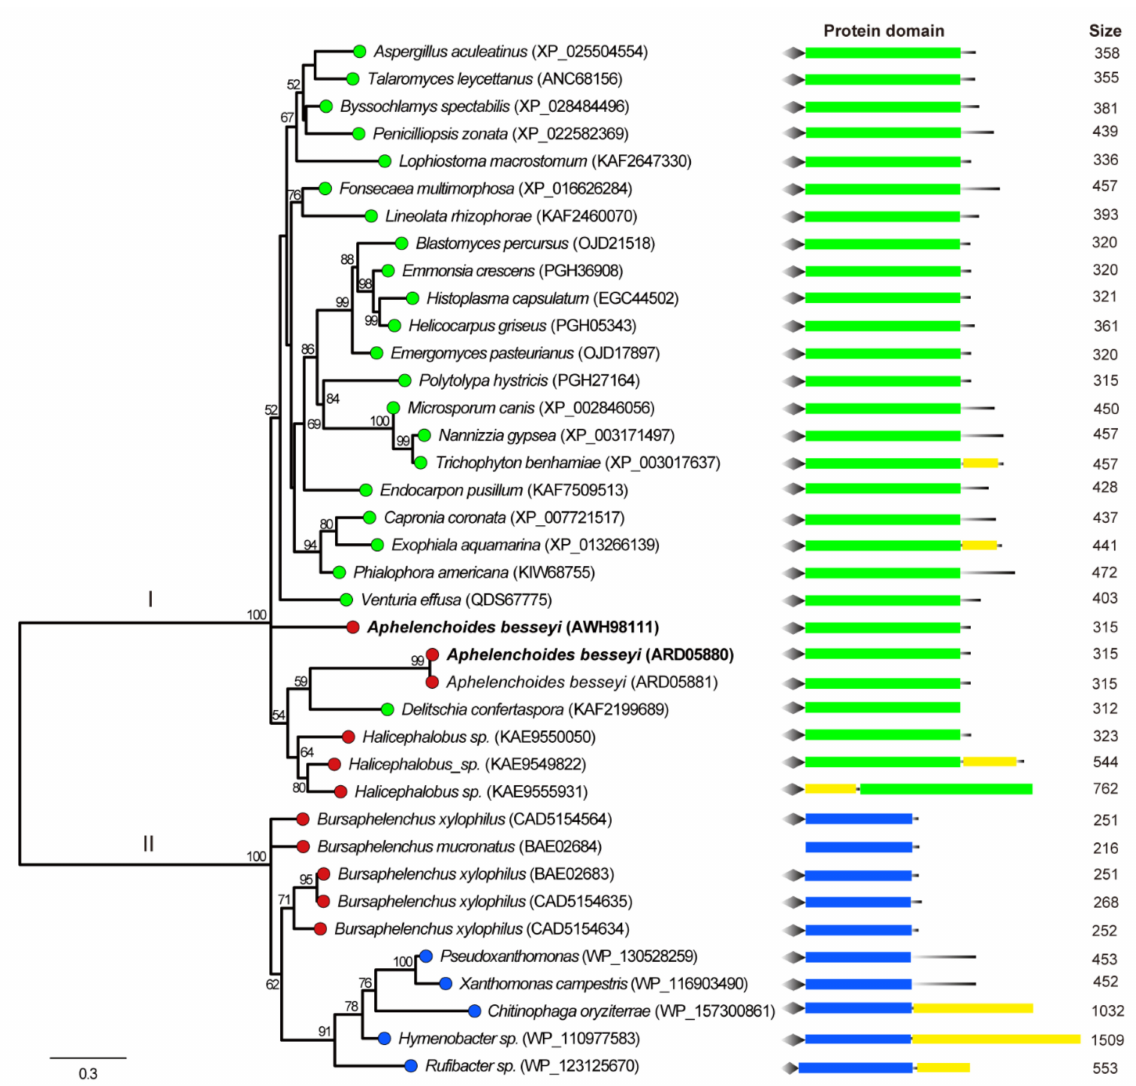
Figure 3. Phylogenetic relationship of nematode GH16 proteins and their relatives from the NCBI database. The branch length of the maximum likelihood tree indicates evolutionary distance. One thousand bootstrap replicates were performed, and the node labels represent the percentage of bootstrap support. The branches with different colored circles corre- spond to different taxonomic groupings of the species: red = nematodes, green = fungi, and blue = bacteria. A. besseyi GH16-1 and AbGH16-2 is highlighted in bold. The conserved regions and the relative positions of domians in the GH16 protein are shown. Diamond = signal peptide, green rectangle = fungal-specific Lam16A glucanase domain, blue rectangle = laminarinase-like domain, yellow rectangle = other domain(s). The black line at the end of the protein domain schema indicates the relative position of the domains with respect to the C-terminal of the